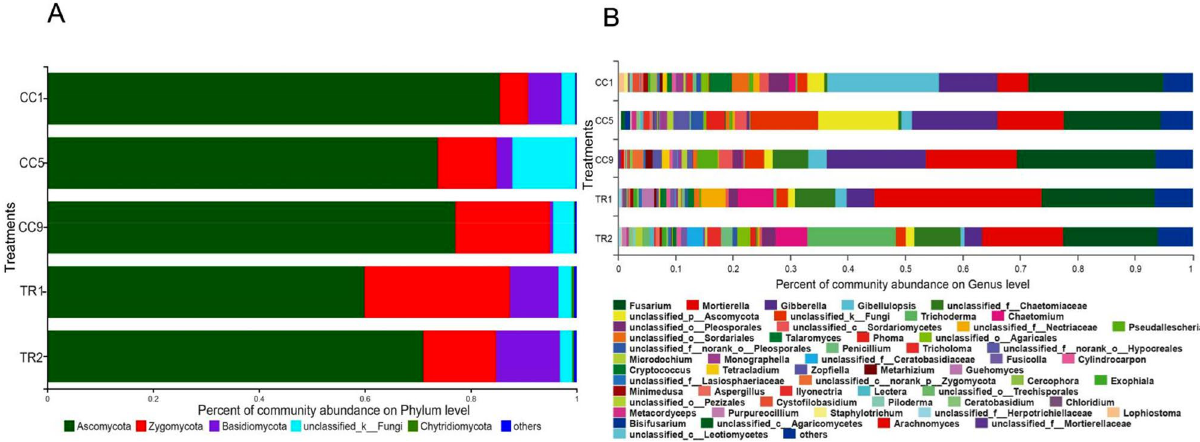
Figure 3. Fungal clustering accumulation map in pepper rhizosphere soil at the phylum ( A ) and genus ( B ) levels. CC1, CC5 and CC9, represent the plots where pepper had been continuously planted for 1, 5 and 9 years, respectively, and TR1 and TR2 represent CC9 plots in which the MHT1134 biocontrol fermentation broth had been applied 1 and 2 years in advance, respectively.